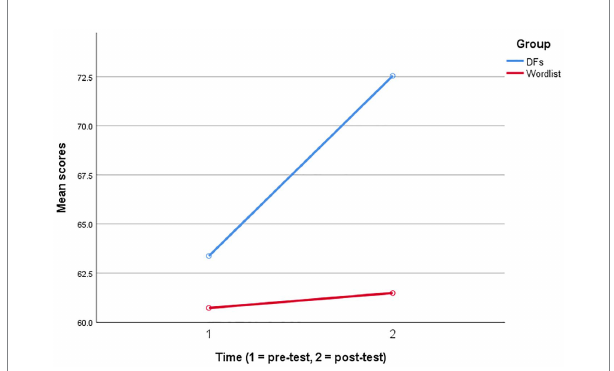
FIGURE 1 Estimated marginal means for self-regulatory capacity.